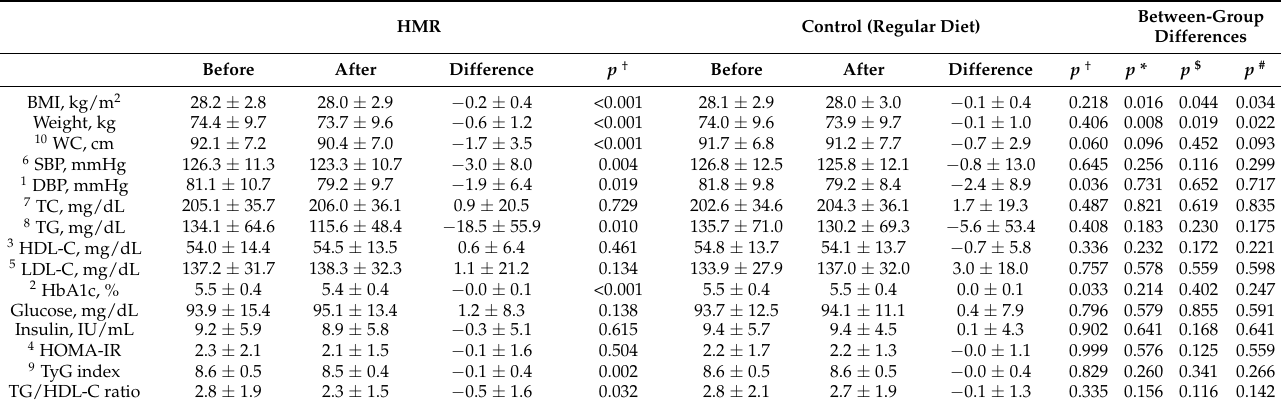
Table 3. Differences in the cardiometabolic parameters after the intervention.